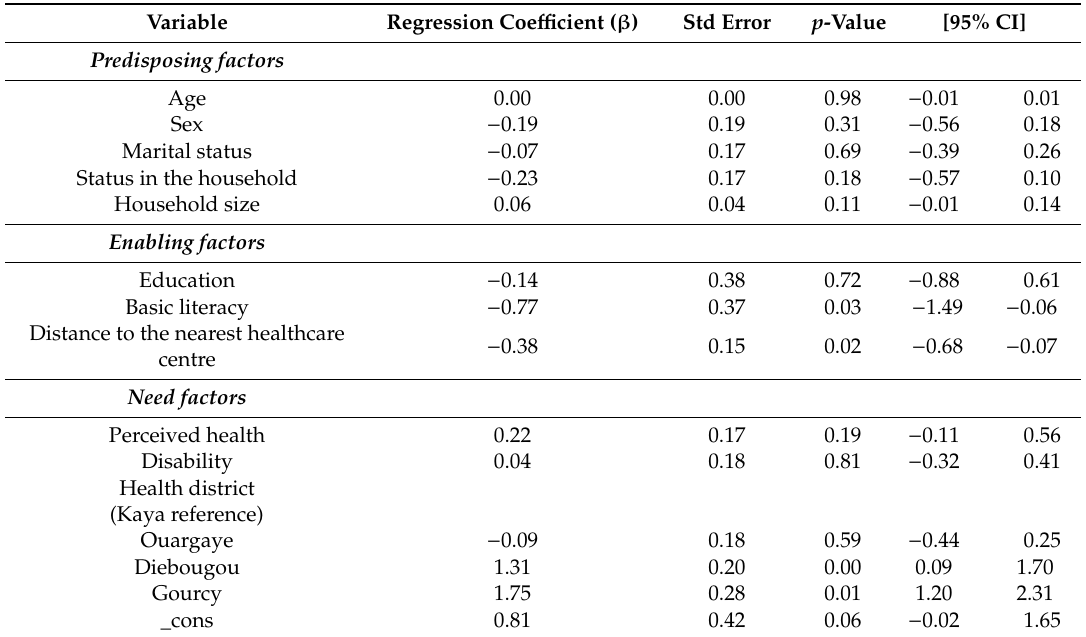
Table 4. Regression model on user fee exemption card